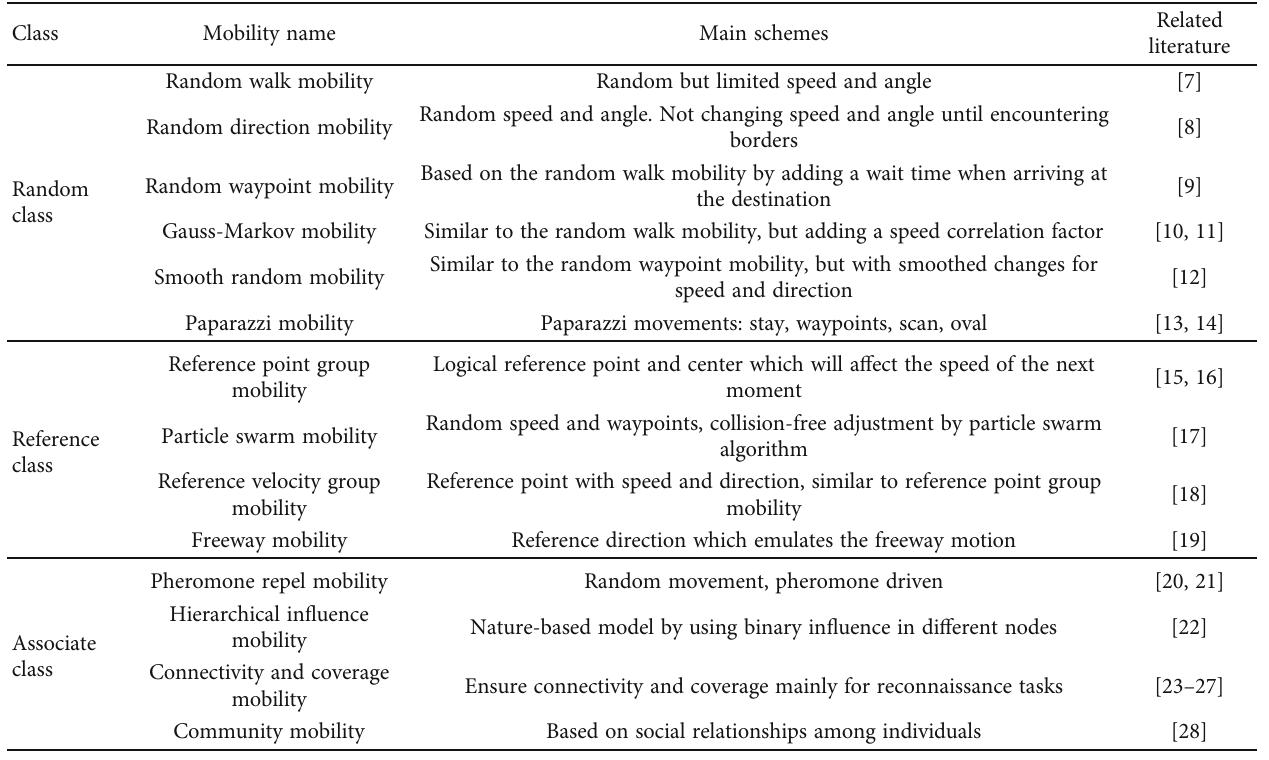
Table 1: Mobility model categories in Ad hoc in recent